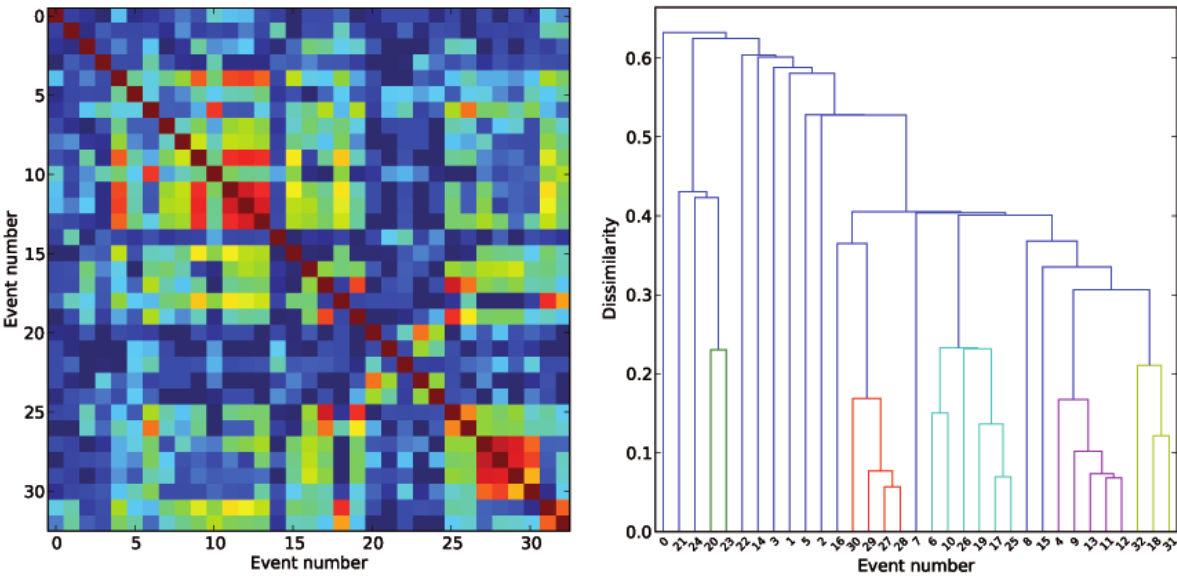
Figure 3. Left: Dissimilarity data for a set of 33 earthquakes. Bluish colors represent high, reddish colors represent low dissimilarities. Right: Dendrogram representation of the hierarchical clustering. Groups of events below the specified dissimilarity threshold are plotted in the same